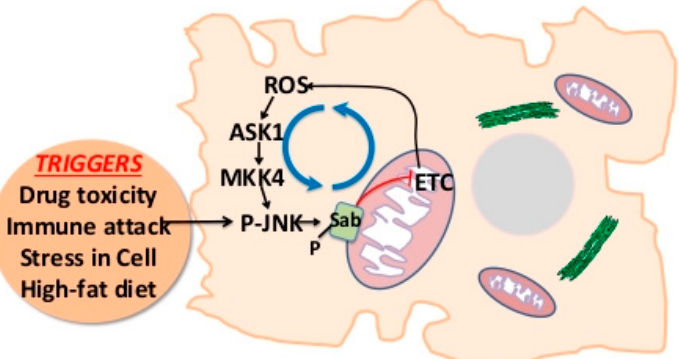
Figure 1. P-JNK-SAB-mitochondria-ROS-mediated JNK activation loop. JNK activation is triggered by physical and chemical stress, including alterations in nutrients, growth factors, cytokines, extracellular matrix, DNA damage, drugs, and toxins. Activated JNK translocates to mitochondria and interacts with SAB, leading to a sequence of events, i.e., inhibition of intramitochondrial c-SRC activity and JNK. P-JNK-SAB-ROS activation loop drives sustained JNK activation, and cell death occurs. Black arrows indicate activation. Blue circulating arrows indicate vicious cycle. Red “T” arrow indicates inhibition of electron transport chain